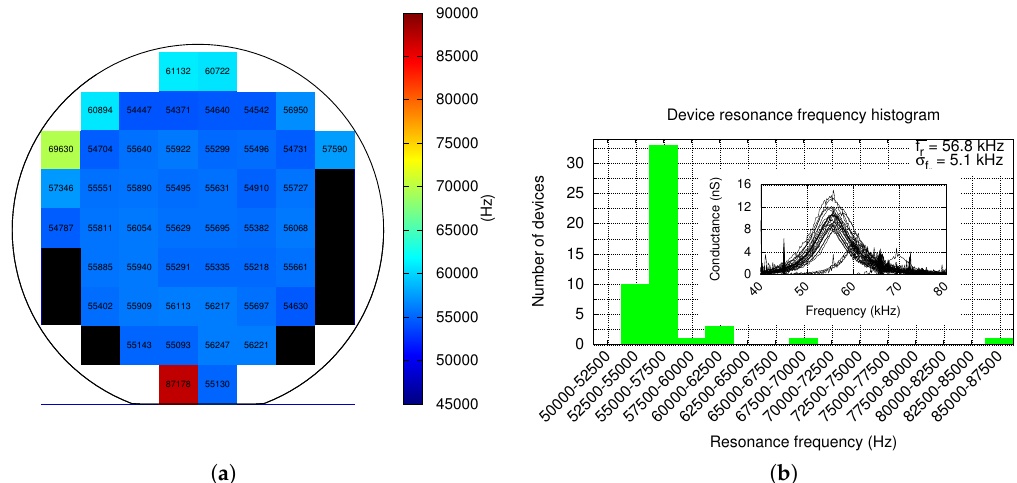
Figure 10. Wafer level measurements of device resonance frequency distribution map ( a ), and the histogram ( b ). All resonance measurements are included in the inset of the latter.